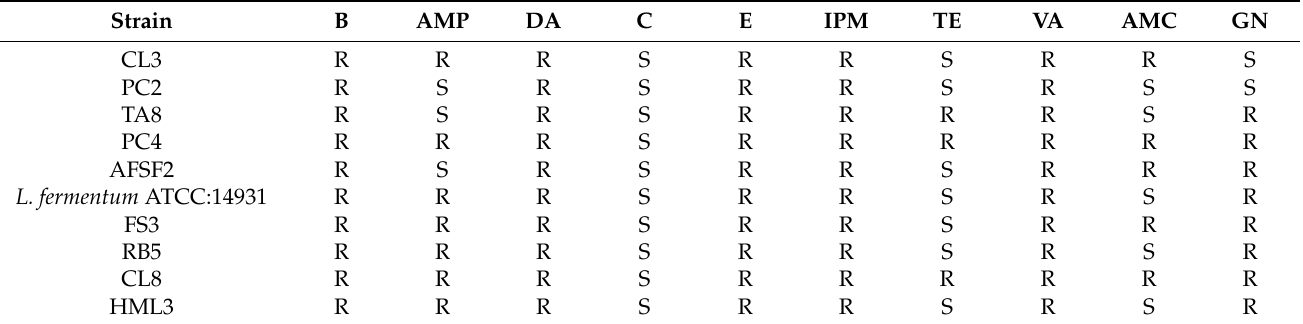
Table 2. Antibiotic susceptibilities of seven isolated strains of Lactobacillus and two reference strains. Strain